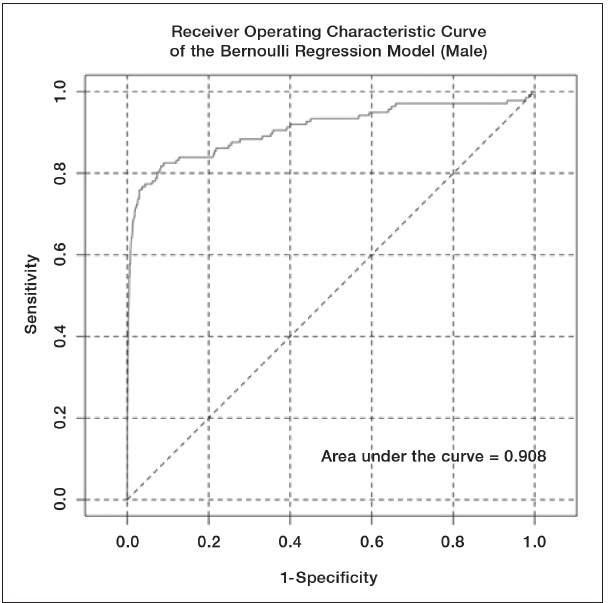
Figure 2) ROC curve for the Bernoulli regression output for women to predict C282Y homozygotes in 27,486 Caucasian women from the Hemochromatosis and Iron Overload Screening (HEIRS) Study. The area under the curve was 0.887 and the Nagelkerke pseudo R-squared was